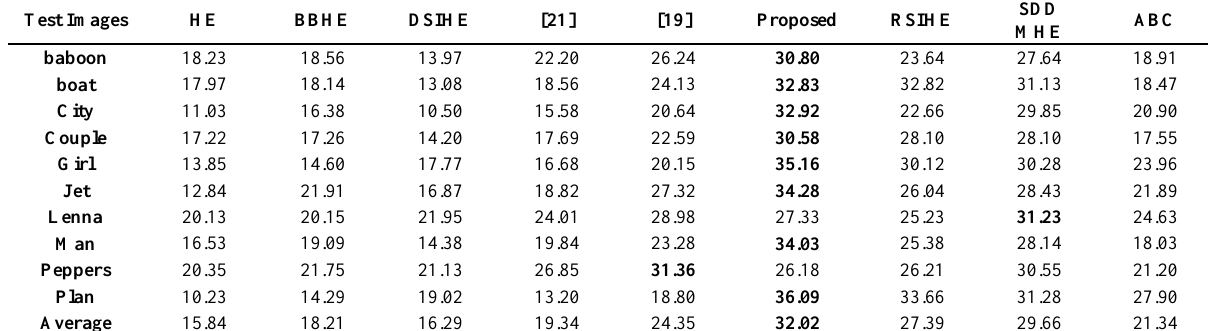
Table 2. Comparing various methods with PSNR.